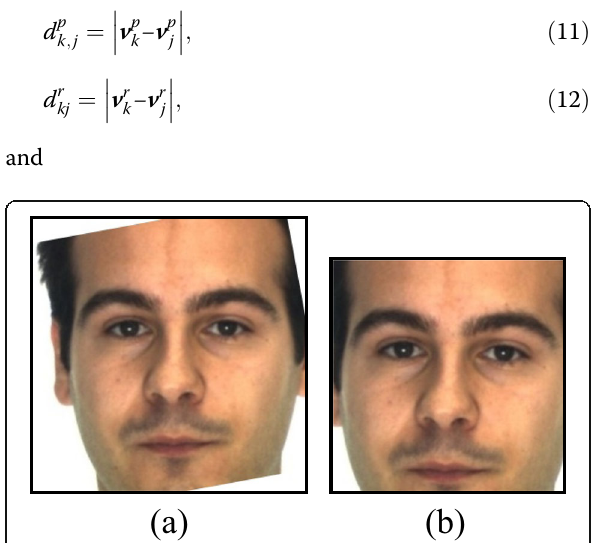
Fig. 11 Alignment face images. a Facial image after rotating. b Facial image after cropping Fig. 12 Composition of multiple features for the MSR